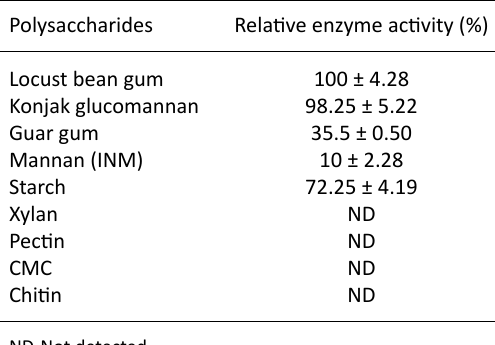
Table 2. Substrate specificity of β-mannanase of P.